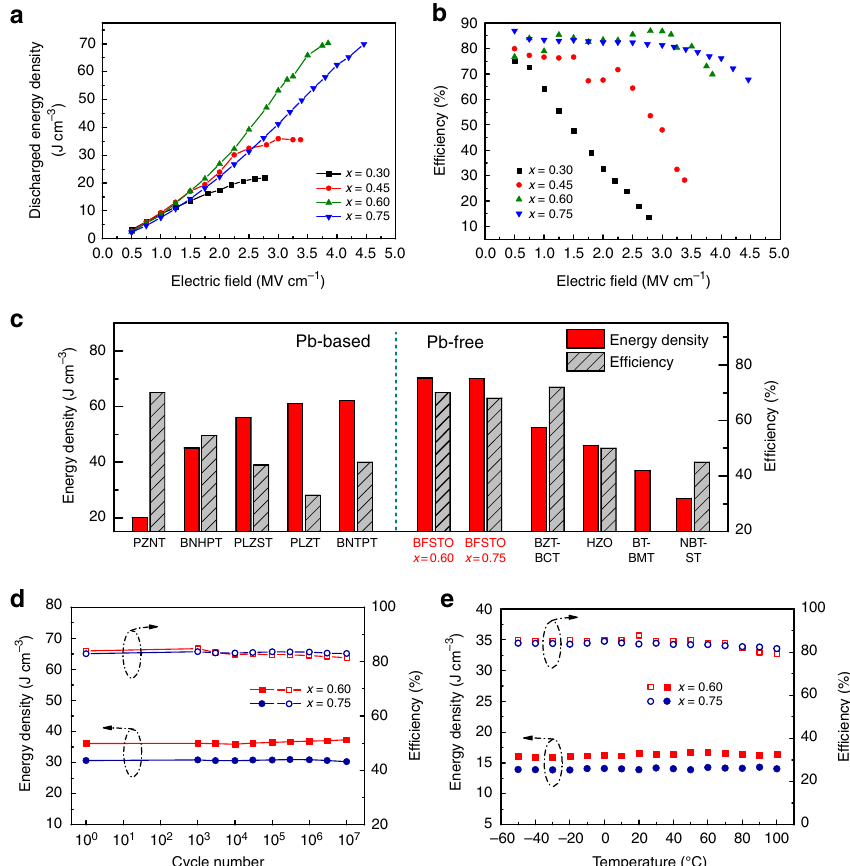
Fig. 3 Energy storage performance. a Discharged energy density and b ef fi ciency of the BFSTO fi lms as a function of the applied electric fi eld. c Comparisons of energy density and ef fi ciency between BFSTO and representative dielectric systems 10 – 12,28 – 33 , showing that the BFSTO fi lms possess the most outstanding energy storage performance. d Energy density and ef fi ciency for x = 0.60 and 0.75 at an electric fi eld of 2.5 MV cm − 1 over 1 × 10 7 charging-discharging cycles. e Temperature-dependent energy storage performance for x = 0.60 and 0.75 at an electric fi eld of 1.5 MV cm −